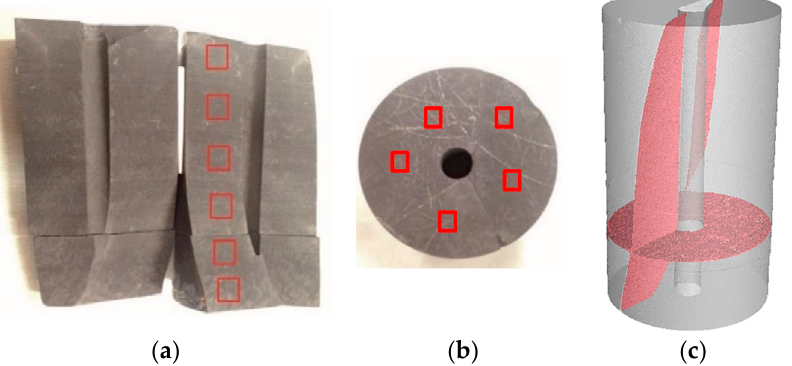
Figure 3. Specimen after testing: ( a ) locations of the slices collected from the newly produced PF; ( b ) locations of the slices collected from the RF and ( c ) CT reconstruction of both hydraulic fractures in the shale specimen.